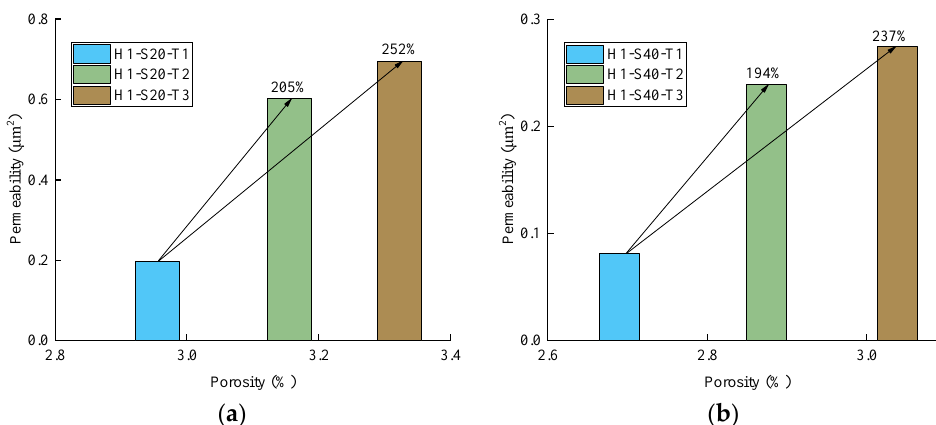
Figure 19. Relationship between the permeability and porosity of TRC (H1); ( a ) Grid size 20 mm × 20 mm; ( b ) Grid size 40 mm × 40 mm.